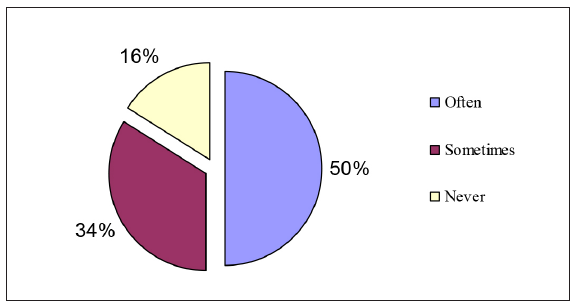
Fig. 1. Distribution of physical activity frequencies between men and women (in percent)